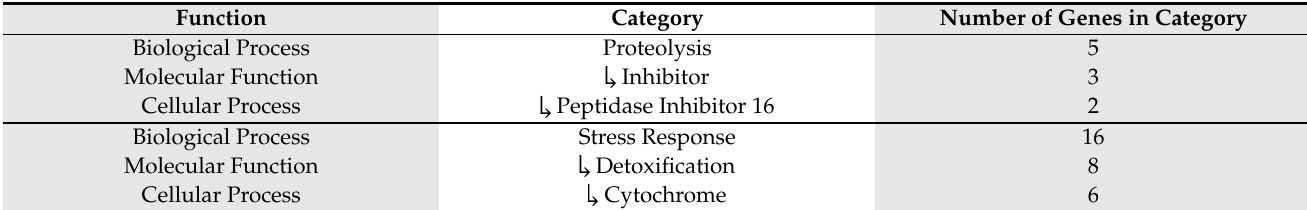
Table 3. WormCat Enrichment Results for all DEGs combined.